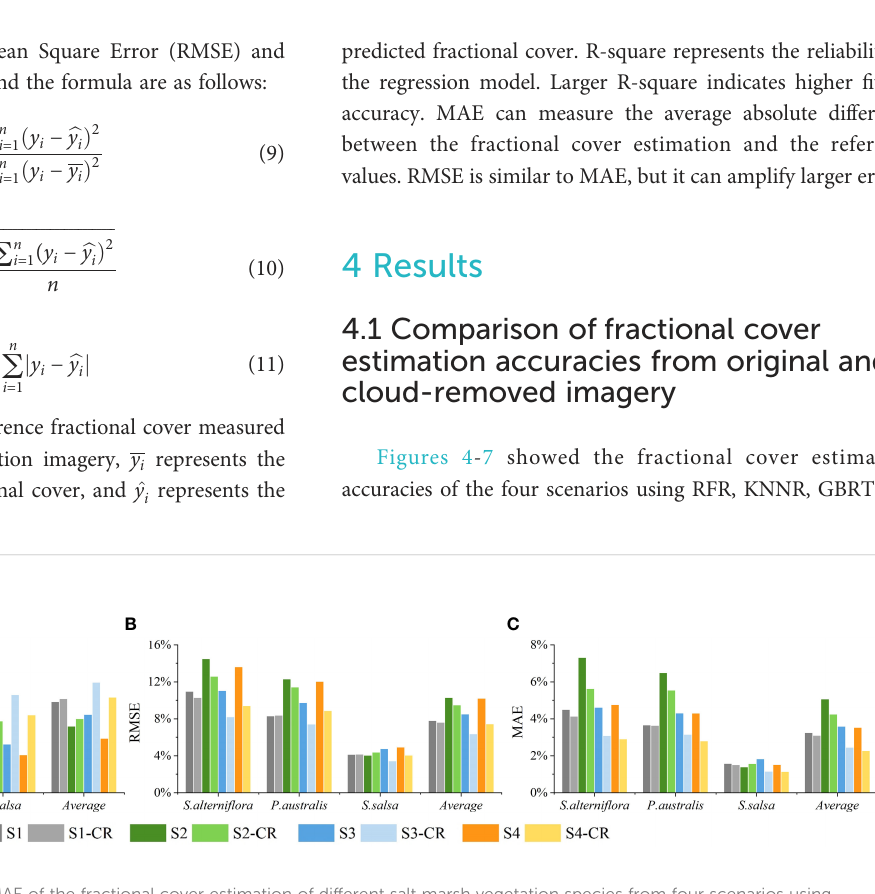
FIGURE 3 Flowchart of the